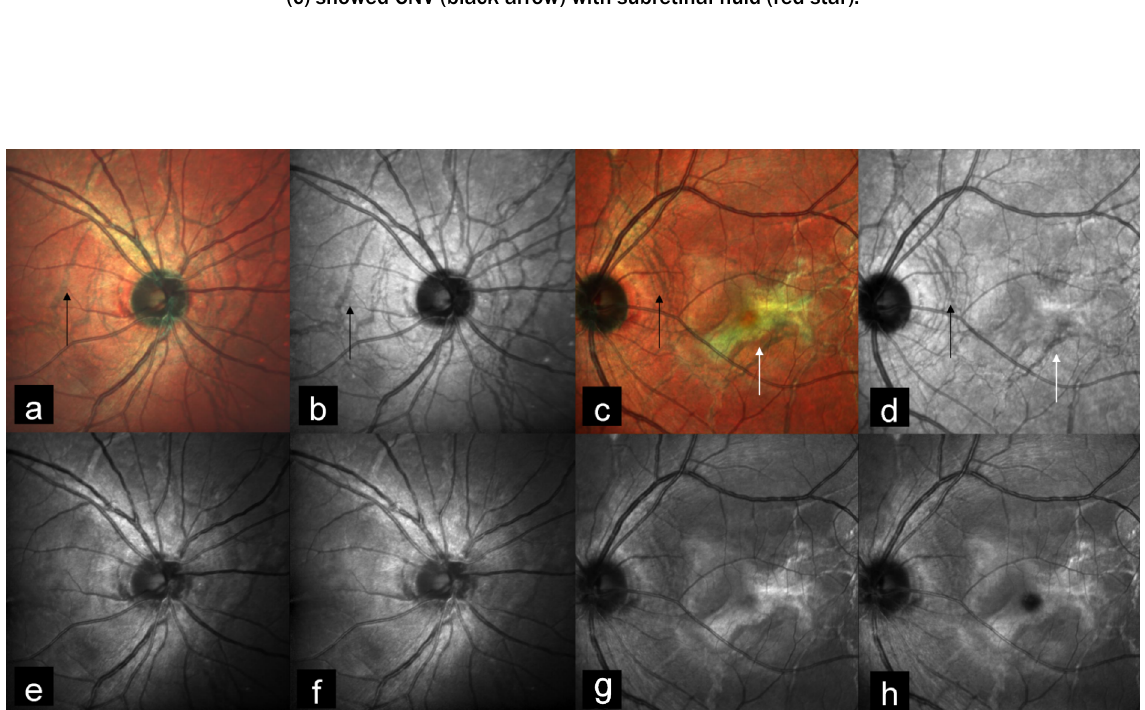
Figure 2: Multicolor imaging (MC) of both eyes highlighted AS in dark orange color (a, c) (black arrows). AS were better visualized in infrared reflectance (IR) (b, d) (black arrows) as compared to green reflectance (GR) (e, g) and blue reflectance (BR) (f, h). MC of the left eye showed CNV in greenish color (c) (white arrow) with corresponding IR (d), GR (g) and BR (h)